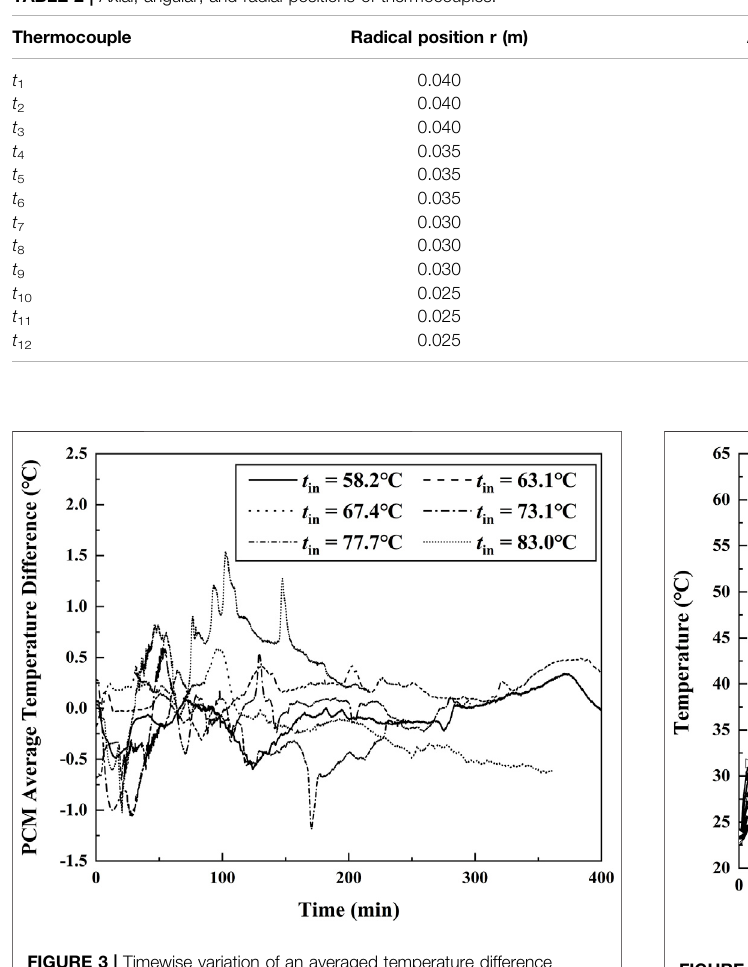
FIGURE 4 | Transient temperatures during the melting process at some points for t in = 63.1 ° C, α = π